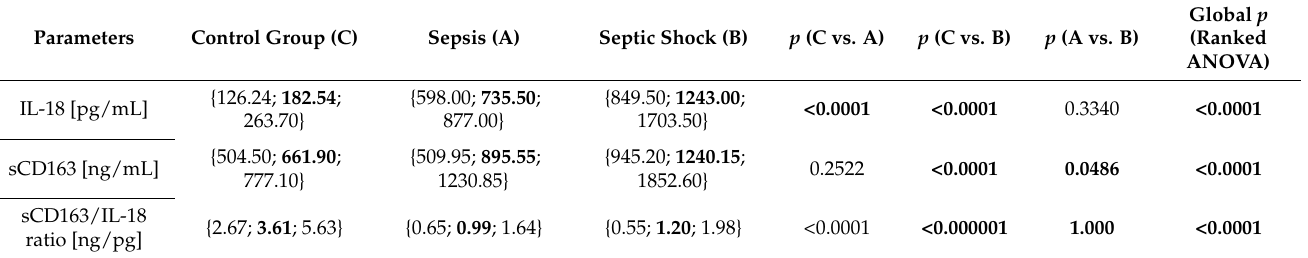
Table 2. First-day values of selected parameters in the three studied groups: control group, sepsis and septic shock.